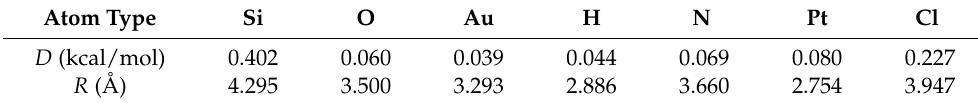
Table 1. The values of van der Waals diameter and well-depth used in this work [18].